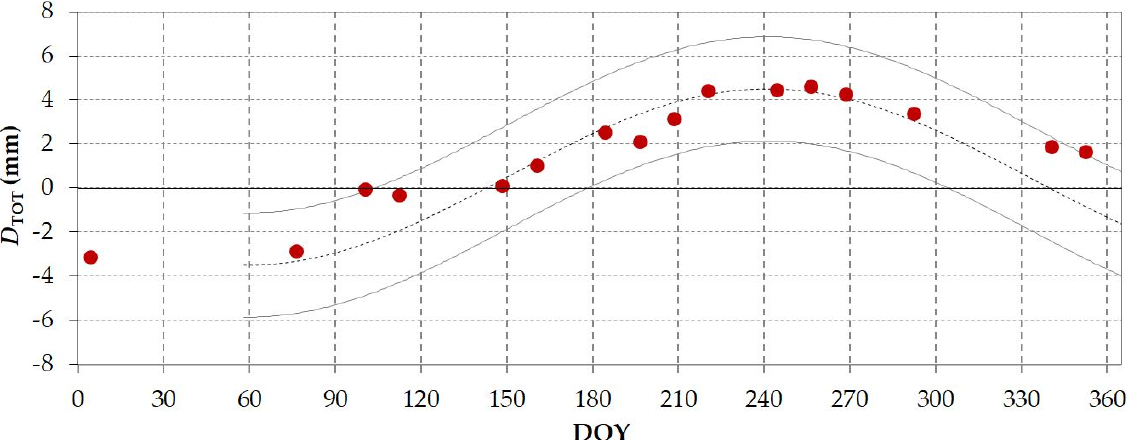
Figure 9. The temporal behaviour (DOY in x -axis) of the horizontal total displacements orthogonal to the dam ( D TOT , mm) is estimated via PS–InSAR (red dots). A sinusoidal interpolation curve (continuous dashed line) and a confidence band of ± 2 × σ XY between measured and interpolated values (dark grey lines) are reported to facilitate the interpretation of the phenomenon.